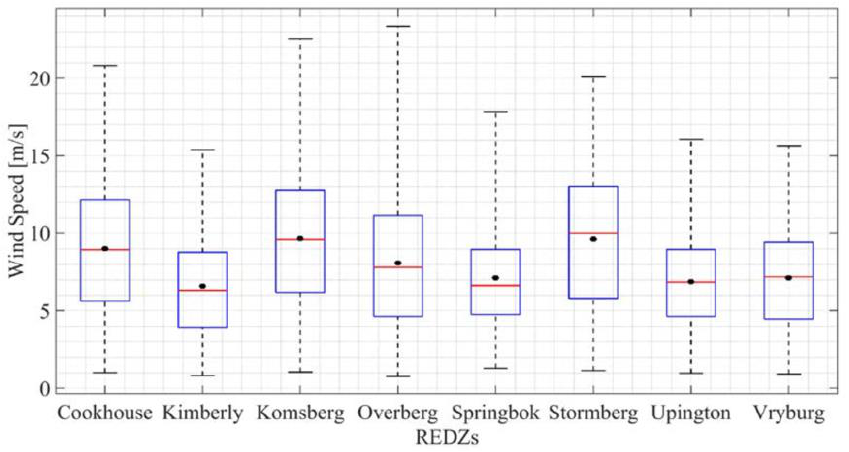
Figure 26. Boxplot showing the daily mean, median, and variance characteristics of the wind speed using the standard deviation method [22].